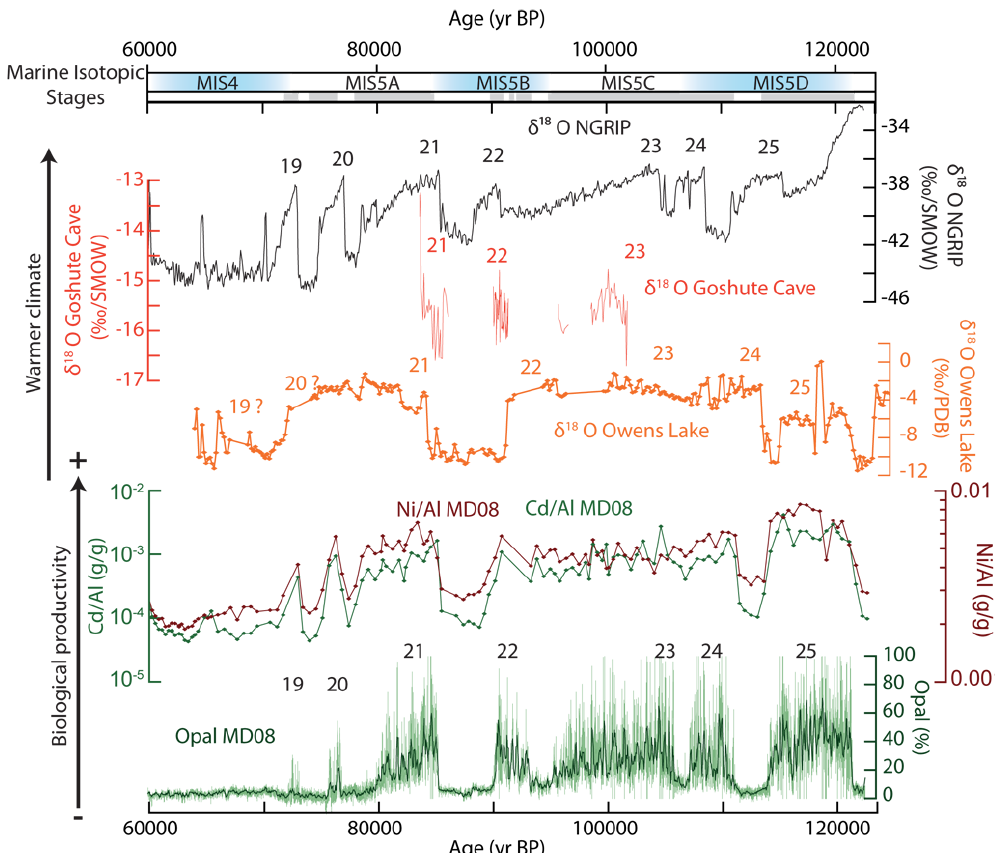
Fig. 4. The isotopic composition of NGRIP ice core ( δ 18 O‰/SMOW) (NGRIP Members, 2004) ; the isotopic composition of Owens Lake sediment ( δ 18 O‰/PDB) (Li et al., 2004), the isotopic composition of Goshute cave stalagmite ( δ 18 O‰/PDB) (Denniston et al., 2007); and the opal content, Cd/Al, and Ni/Al in MD02-2508